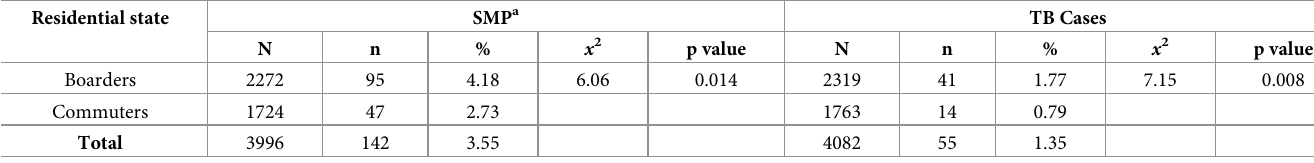
Table 2. SMP and TB cases of students in different residential status.